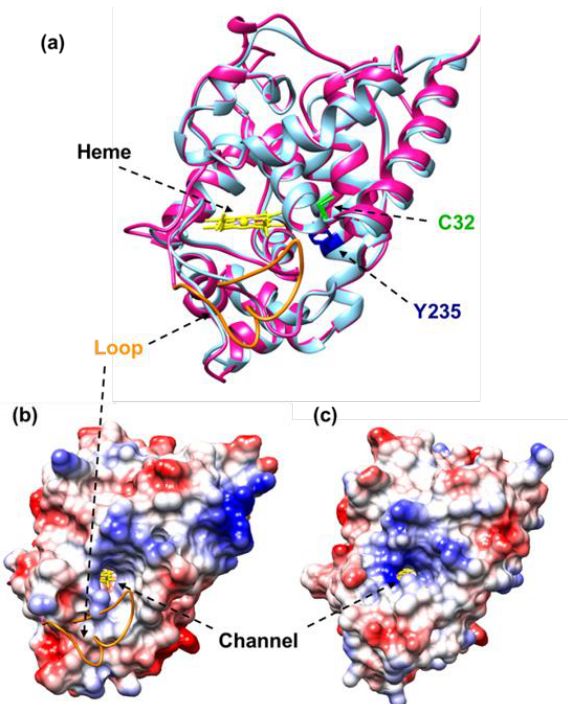
Figure 7. Comparative analysis of the models of plastidial/mitochondrial CaAPX3 and cytosolic CaAPX4. ( a ) Superposition of CaAPX3 (magenta) on CaAPX4 (cyan) showing the extra loop of CaAPX3 in orange, the heme group in yellow, and residues that undergo NO-derived PTMs (C32 in green and Y235 in blue). ( b ) The surface of CaAPX4 shows the position of the CaAPX3 loop (orange) and the access channels connecting the surface with the distal heme pocket. ( c ) The surface of CaAPX3 in the same orientation illustrates how the loop interferes with the orientation of the